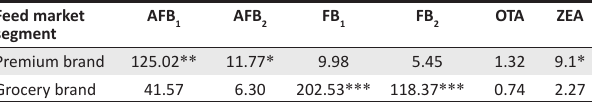
TABLE 4: The results of the high performance liquid chromatographic quantitation of mycotoxins in cat feed extracts. Feed market AFB segment